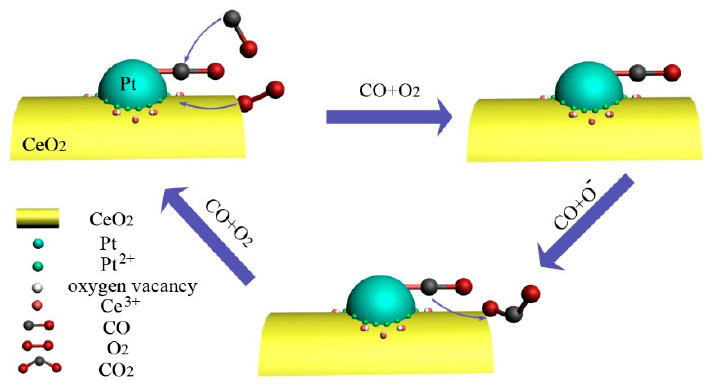
Figure 10. CO oxidation reaction mechanism on the Pt / CeO 2 nanorod catalysts.